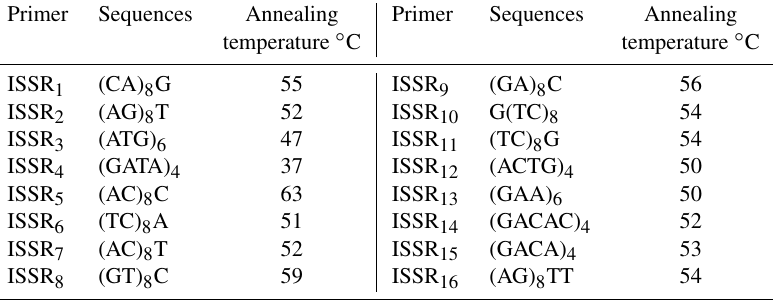
Table 1. List of primers used for ISSR amplification and their annealing